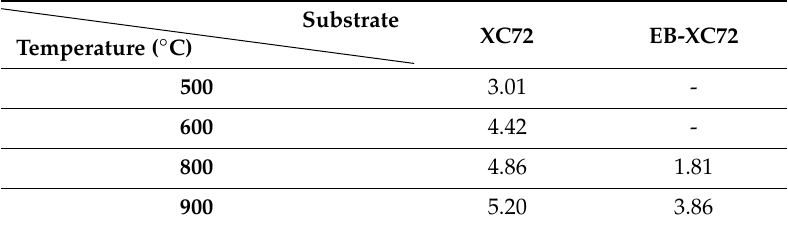
Table 1. Mean crystal size a (nm) of Pt loaded on di ff erent